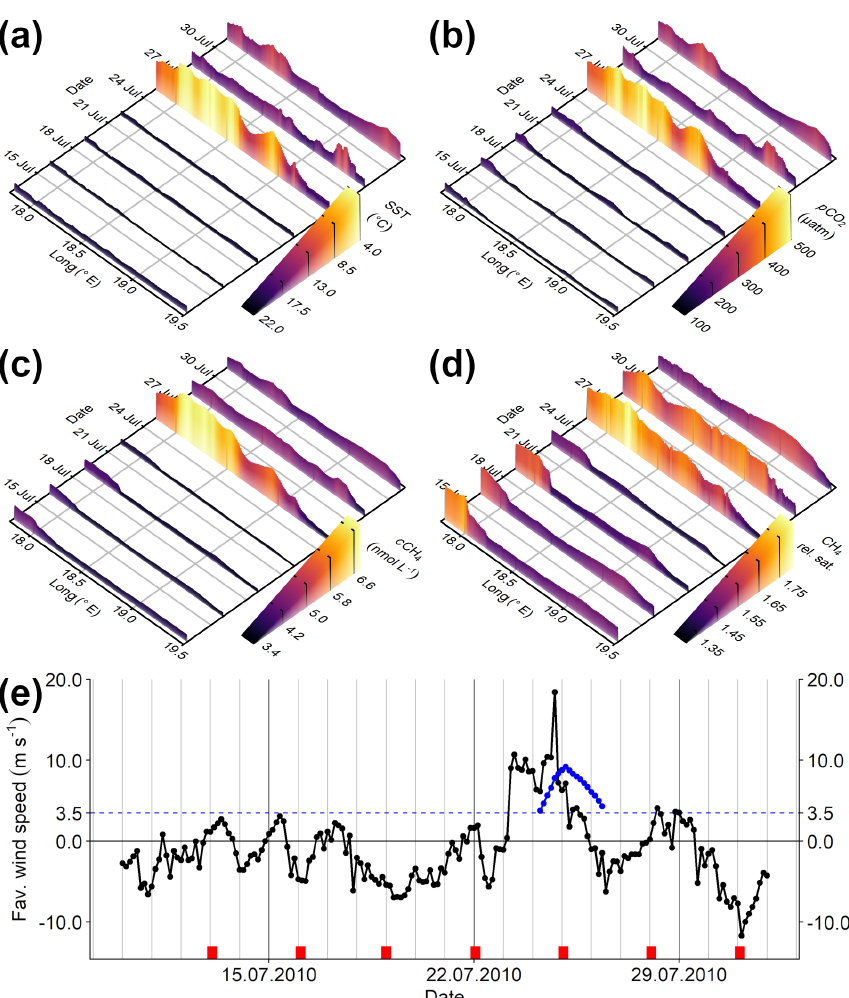
Figure B6. (a) Sea surface temperature, (b) CO 2 partial pressure, (c) CH 4 concentration, and (d) relative CH 4 saturation within the Go-NW box as measured by SOOP Finnmaid on seven transects from 12 to 31 July 2010. In (a–d) , abscissa is position given as longitude, ordinate is time, and the respective variable is displayed by both colour and height of the curve. Please note the inverted SST scale in (a) to highlight the correlation between decreasing SST and increasing p CO 2 and c CH 4 . (e) Upwelling-favourable wind component in the same period: black dots and lines are in 3h intervals; blue dots represent the running 48h mean if this mean is above 3.5ms − 1 . The dashed blue line indicates the chosen threshold of the wind criterion. Red dashes at the bottom mark transects of SOOP Finnmaid within the box (see a–d ). This example shows distinct upwelling signals on 25 July, which vanish quickly after turning wind, hinting at downwelling as the relevant process for fast relaxation of upwelling signals. In fact, post-upwelling values of SST, p CO 2 , and c CH 4 differ only slightly from pre-upwelling